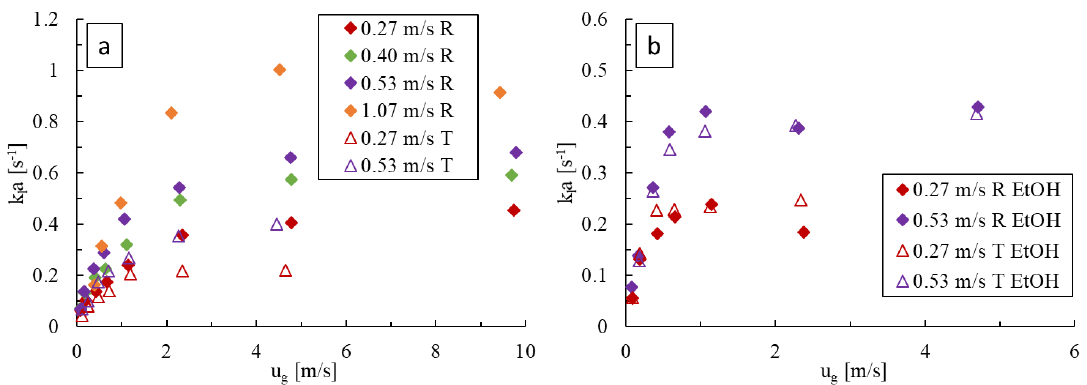
Figure 10. Comparison of 𝑘 𝑙 𝑎 at varying gas and liquid flow rates in the LL-Rhombus (R) and LL- Triangle (T) with ( a ) water and ( b ) 0.5 wt% aqueous ethanol as the liquid phase. (T) with ( a ) water and ( b ) 0.5 wt% aqueous ethanol as the liquid